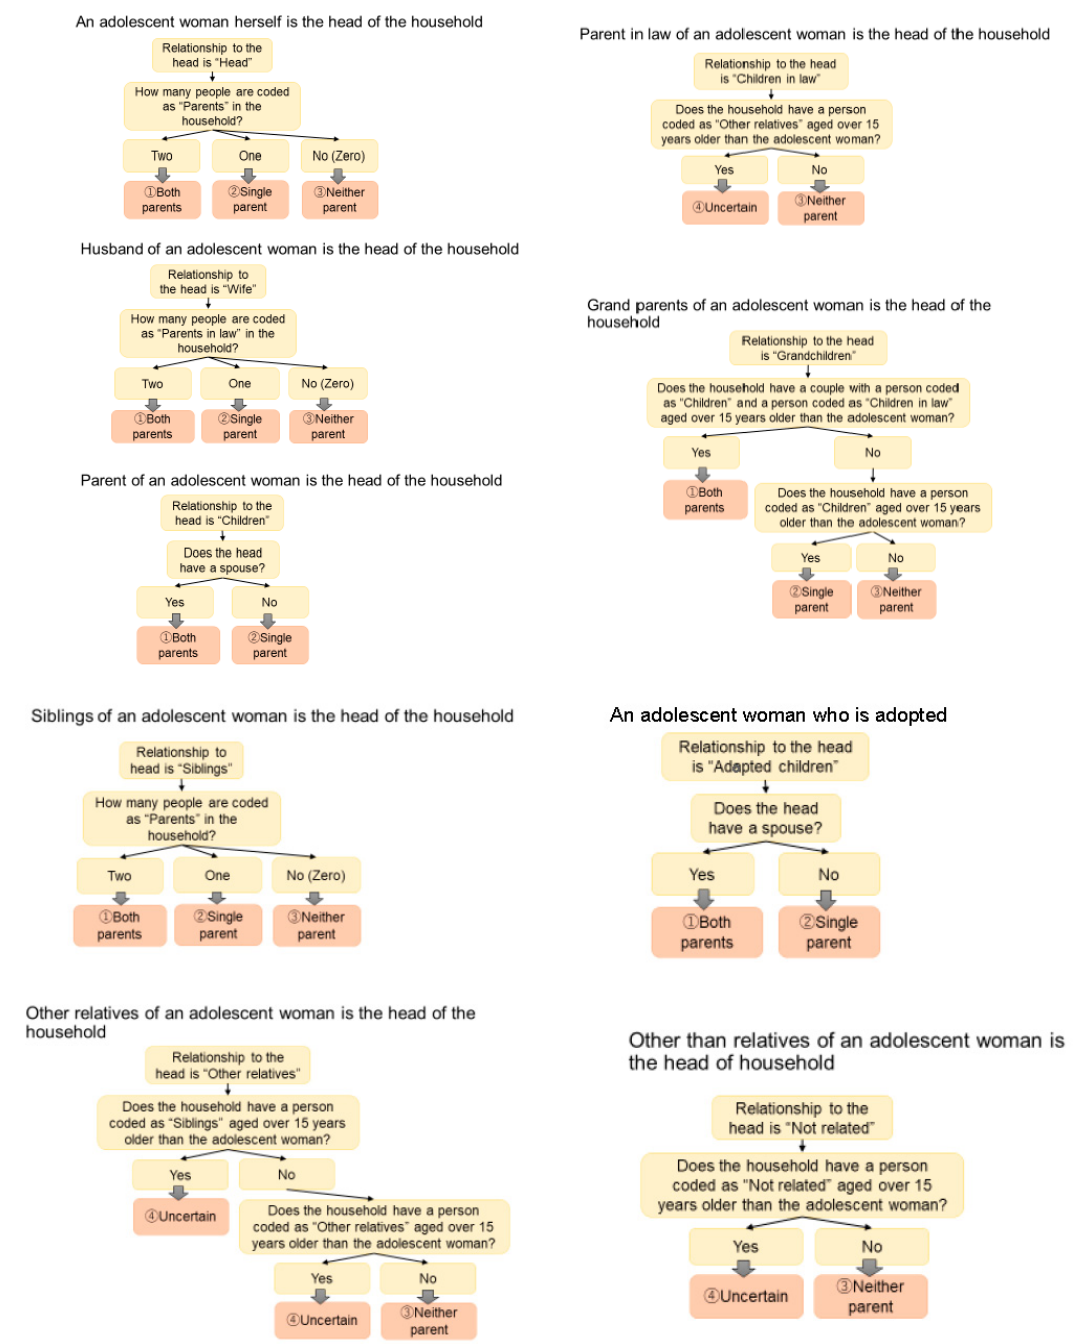
Figure 2. Framework in creating “Parent structure” from the HR raw data. Table 1. List of exposure variables.